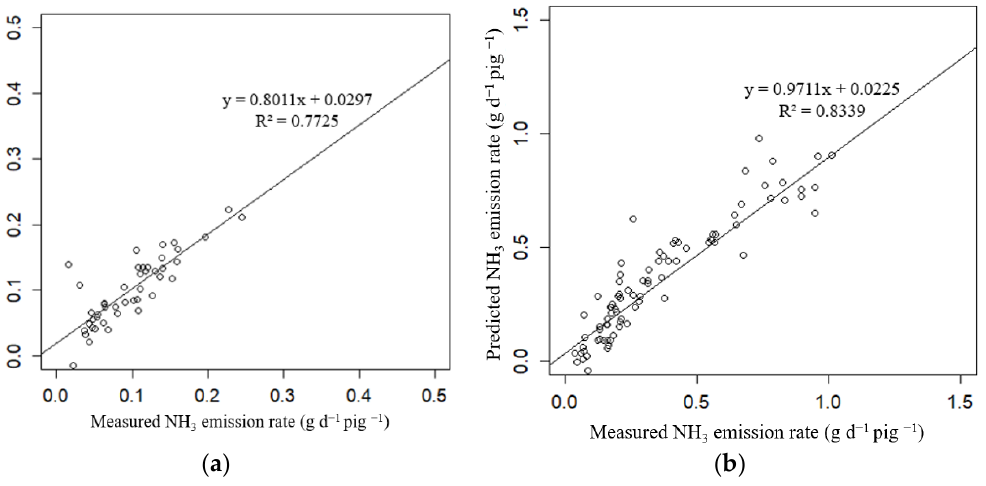
Figure 9. Predicted by multiple linear equation versus the measured NH 3 emission rates. ( a ) Winter; ( b ) Summer.